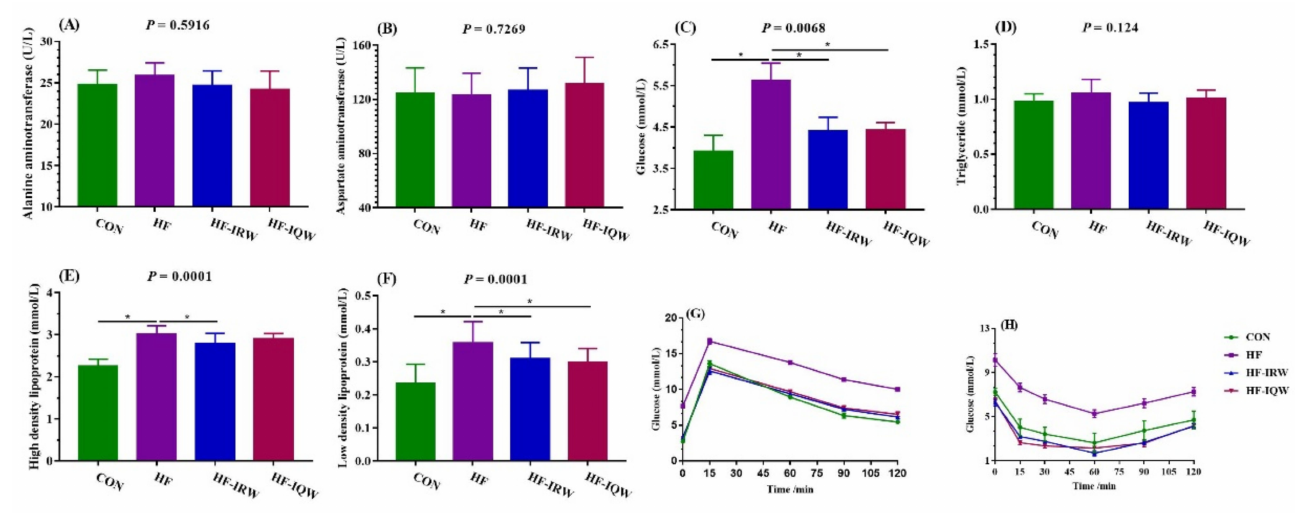
Figure 2. Effects of egg protein transferrin-derived peptides IRW (lle-Arg-Trp) and IQW (lle-Gln-Trp) on the biochemical serum biochemistry, GLU tolerance, and insulin sensitivity of mice fed an HF diet. ( A–F ) The biochemical analyses included alanine aminotransferase (ALT), aspartate aminotransferase (AST), glucose (GLU), triglyceride (TG), high-density lipoprotein (HDL), and low-density lipoprotein (LDL). GLU tolerance was indicated by the changing tendency of GLU after intraperitoneal glucose ( G ), and insulin sensitivity was indicated by the changing tendency of GLU after intraperitoneal insulin ( H ). * indicates p < 0.05 between the HF group and other groups.